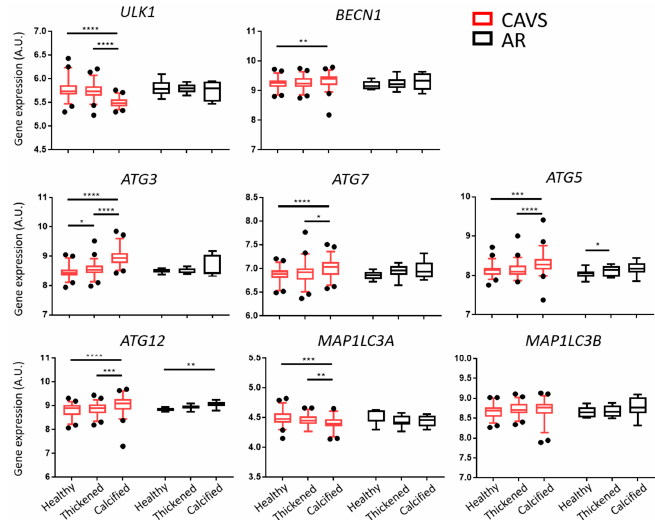
Figure 1. Autophagy pathways are differentially regulated in the calcified tissue of human valves. Gene expression analyses of key autophagy genes in the healthy, thickened, and calcified tissue of human valves from calcific aortic valve stenosis (CAVS; n = 55) and aortic regurgitation (AR; n = 9) patients. Data presented as box-and-whisker plots with 5–95 percentiles. * = p < 0.05, ** = p < 0.01, *** = p < 0.001, **** = p < 0.0001.